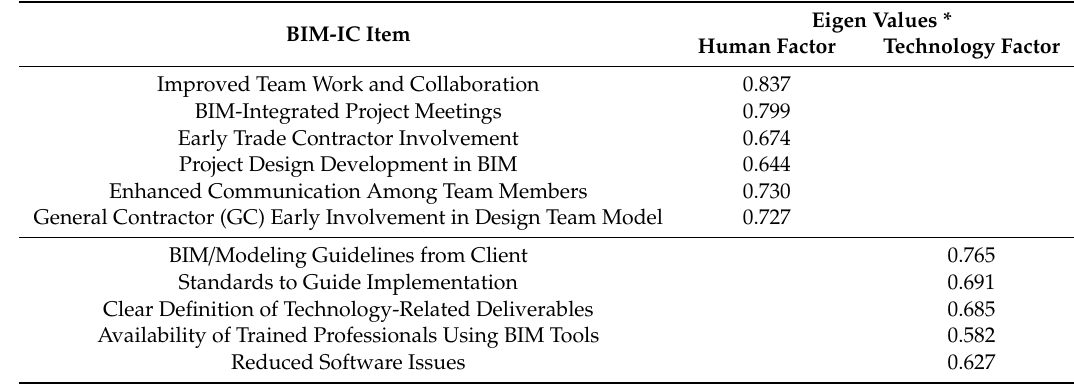
Table 2. Exploratory Factor Analysis: Building Information Modeling (BIM) Implementation